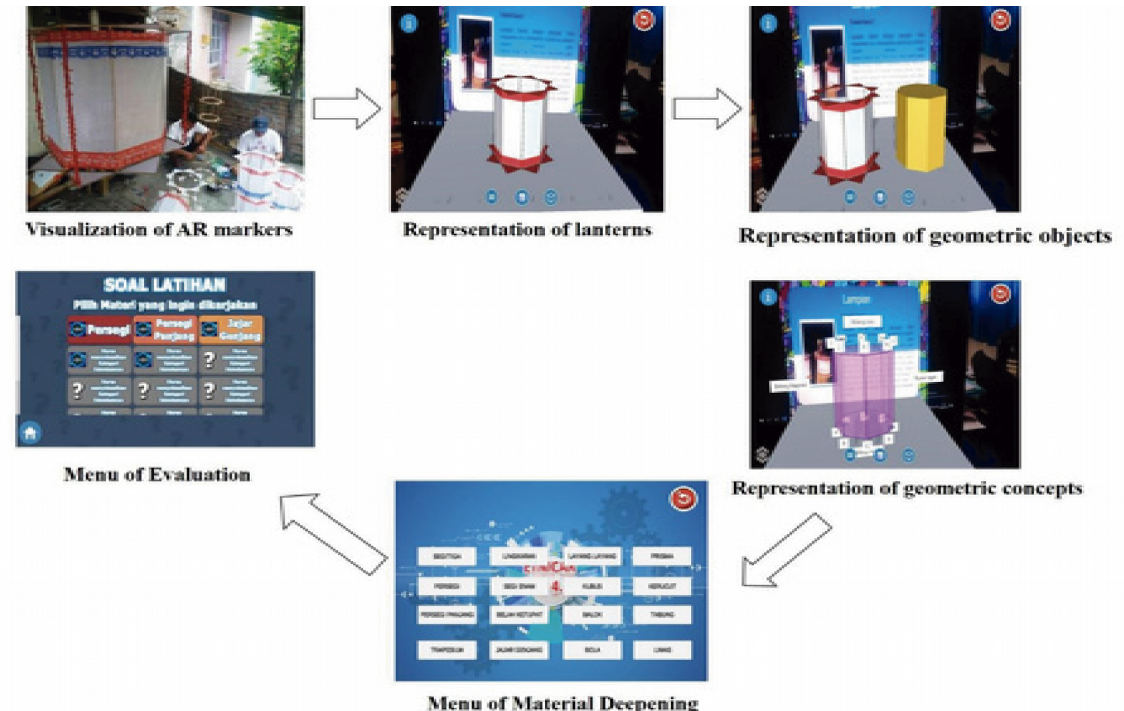
Figure 3. The Process of Using Mobile Augmented